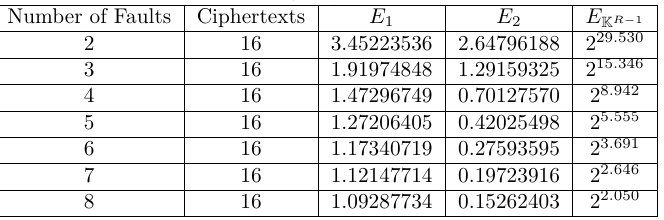
Table 5: The remaining key search space of LED-64.